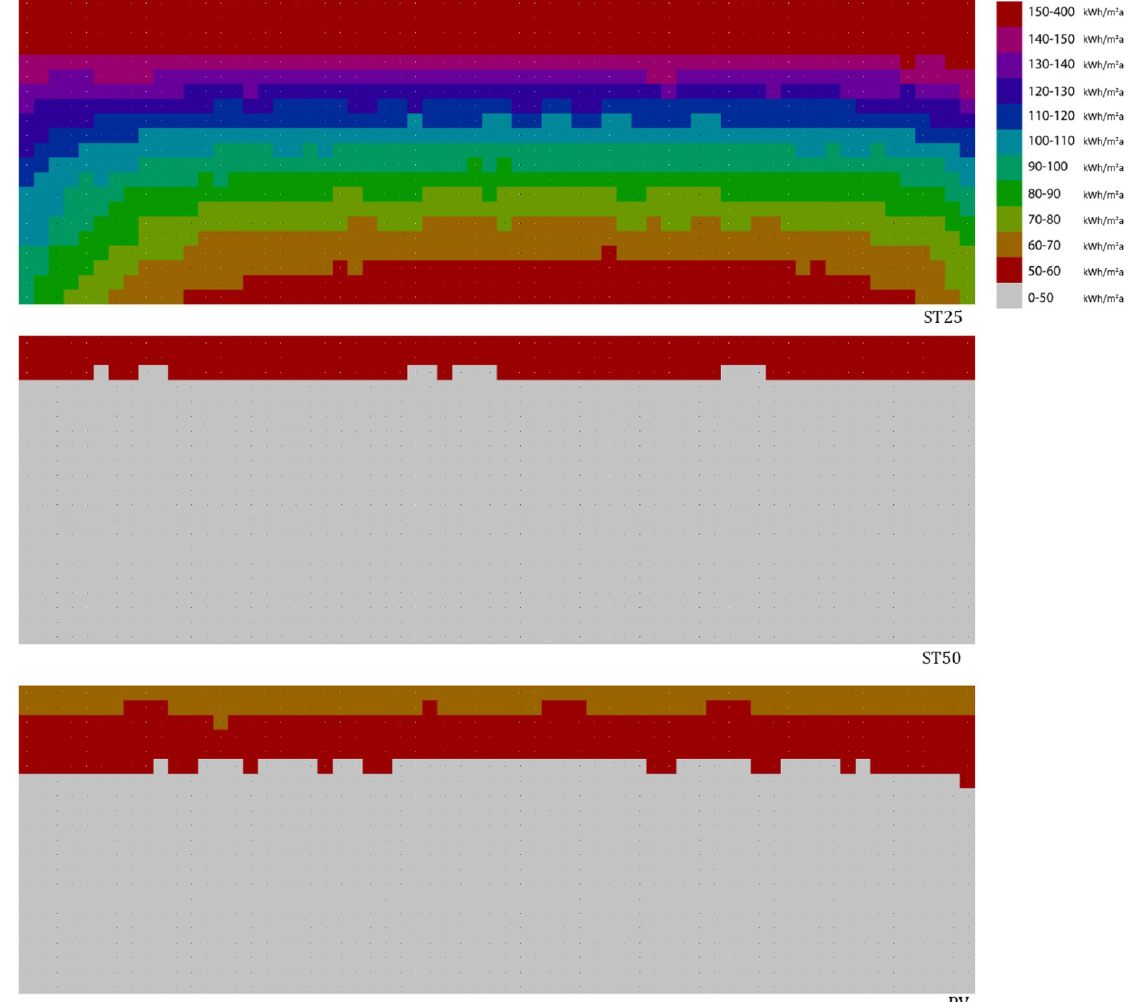
Figure 5. Annual production of ST 25 °C, ST 50 °C and PV at the East façade.